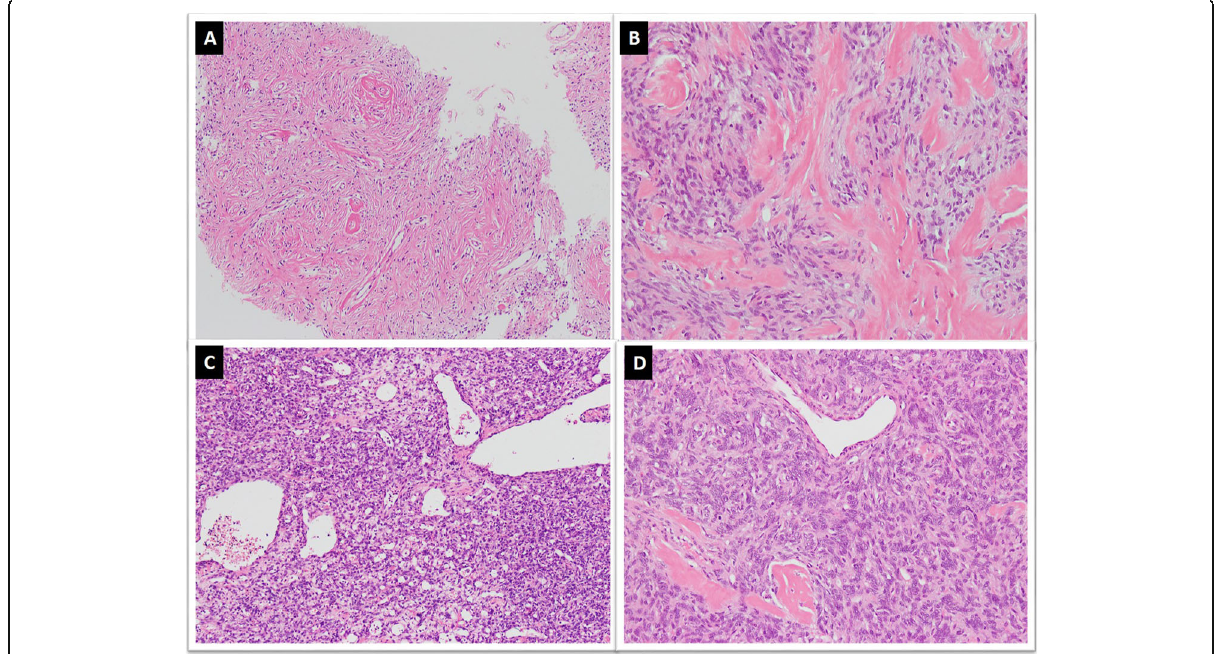
Fig. 3 a . Classic SFT exhibiting cracking artifact and, b . abundant keloid-type collagen, c & d . Cellular SFT exhibiting increased cellularity, gaping blood vessels and more darkly stained nuclei